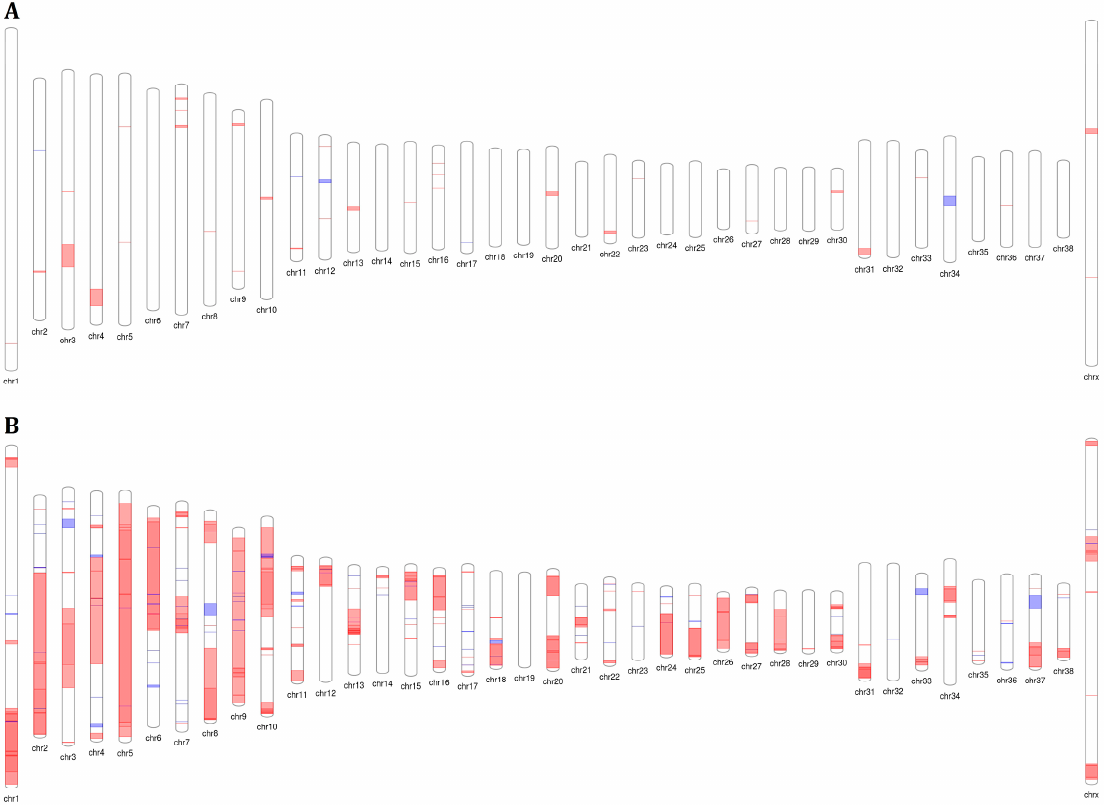
Figure 1. Representative copy number alterations (ideogram) showing gains (blue), and losses (red) in 4 proliferative inflammatory atrophies (PIAs) ( A ) and 14 canine prostate carcinomas ( B